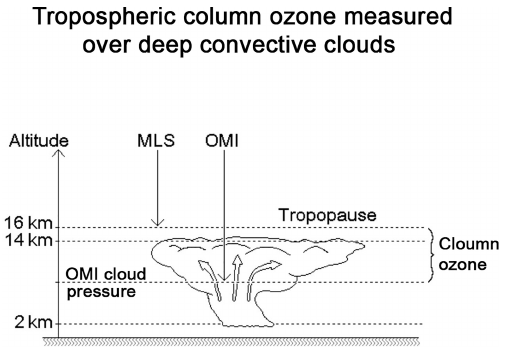
Figure 3. Schematic diagram of the OMI/MLS residual cloud slic- ing method. This depiction shows that deep convective clouds have OMI cloud optical centroid pressures (OCPs) lying deep inside the clouds with cloud tops often at tropopause level or very close to the tropopause. This figure was adapted from Ziemke et al.